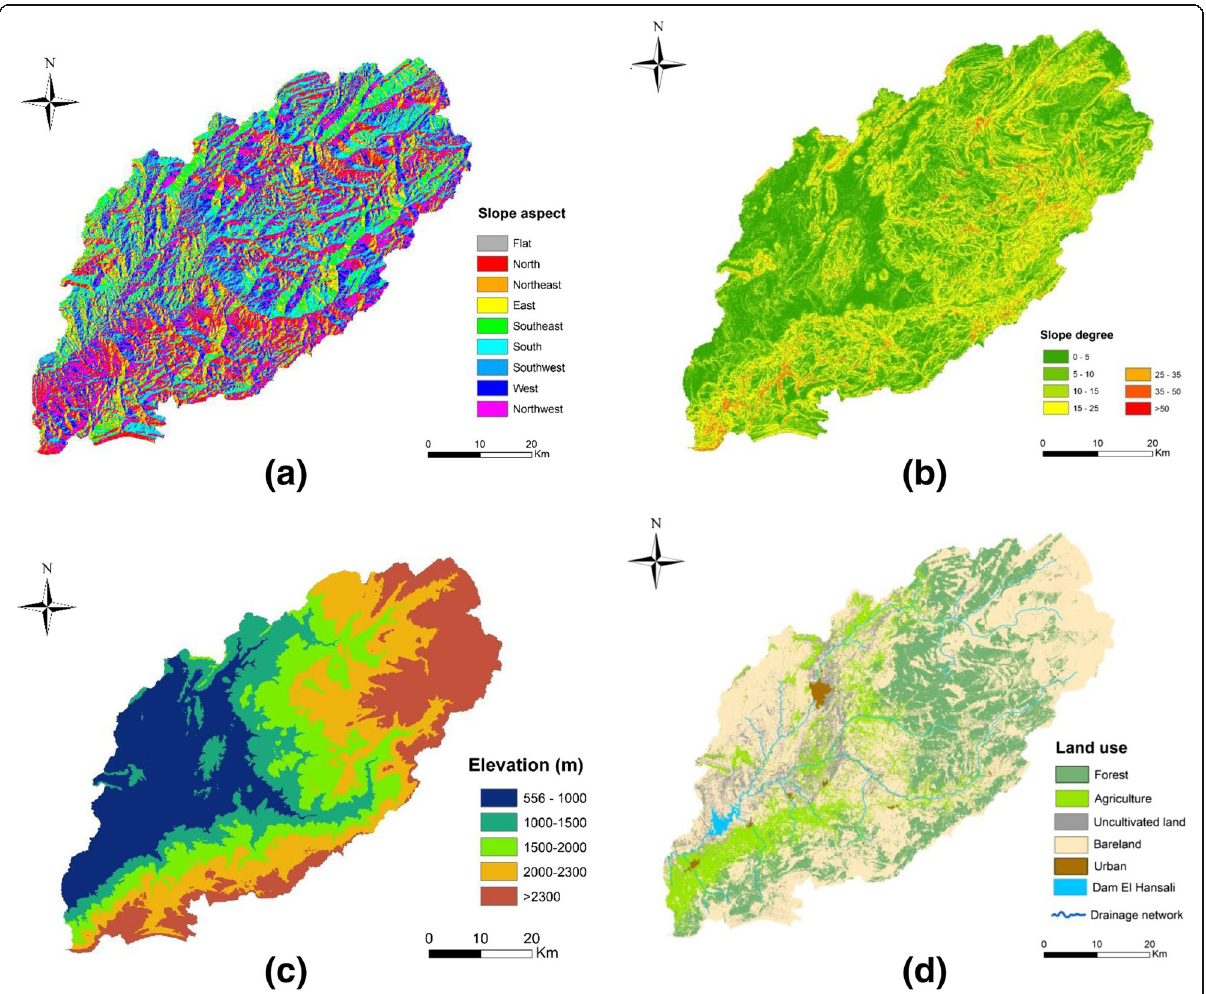
Fig. 2 Landslide contributing-factor layers produced for the study area: ( a ) slope aspect, ( b ) slope degree, ( c ) elevation, ( d ) land